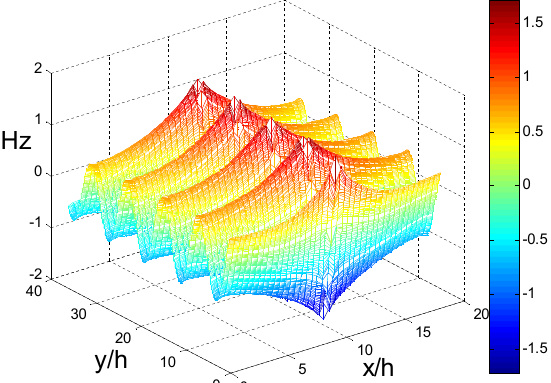
Figure 13. Near field propagation distribution representing the wavelength of 496 nm (Palik experimental data).